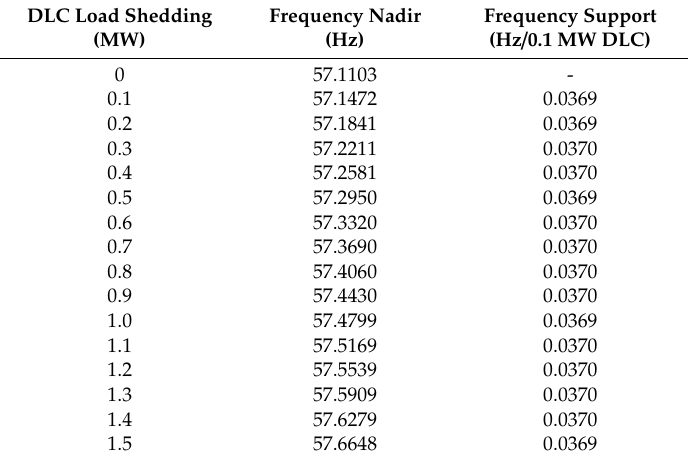
Table 2. The frequency support capability of DLC–case study.